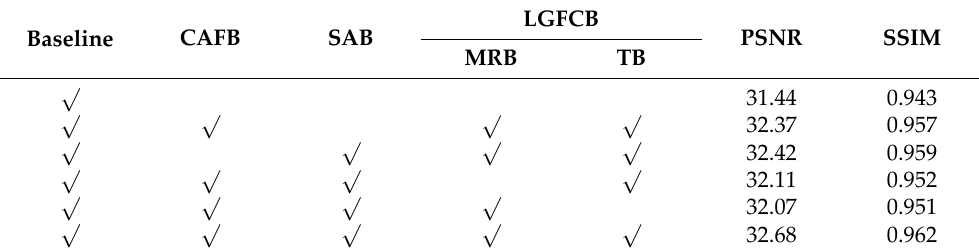
Table 2. Ablation experiment on GoPro dataset [7]. TB indicates the transformer block. The PSNR and SSIM are average results per image.